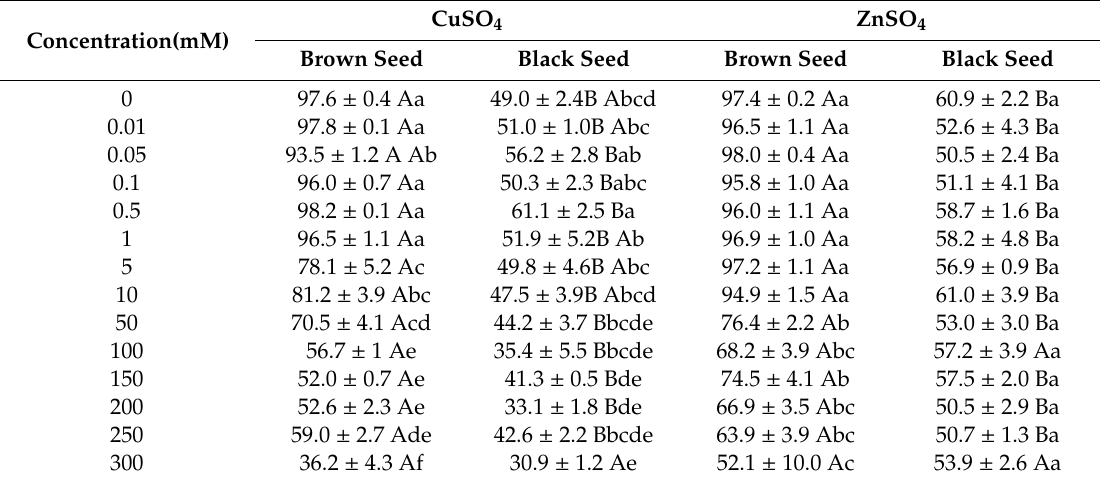
Table 3. E ff ect of CuSO 4 and ZnSO 4 on germination index of dimorphic seeds of S. salsa . CuSO 4 ZnSO 4 Concentration(mM) Brown Seed Black Seed Brown